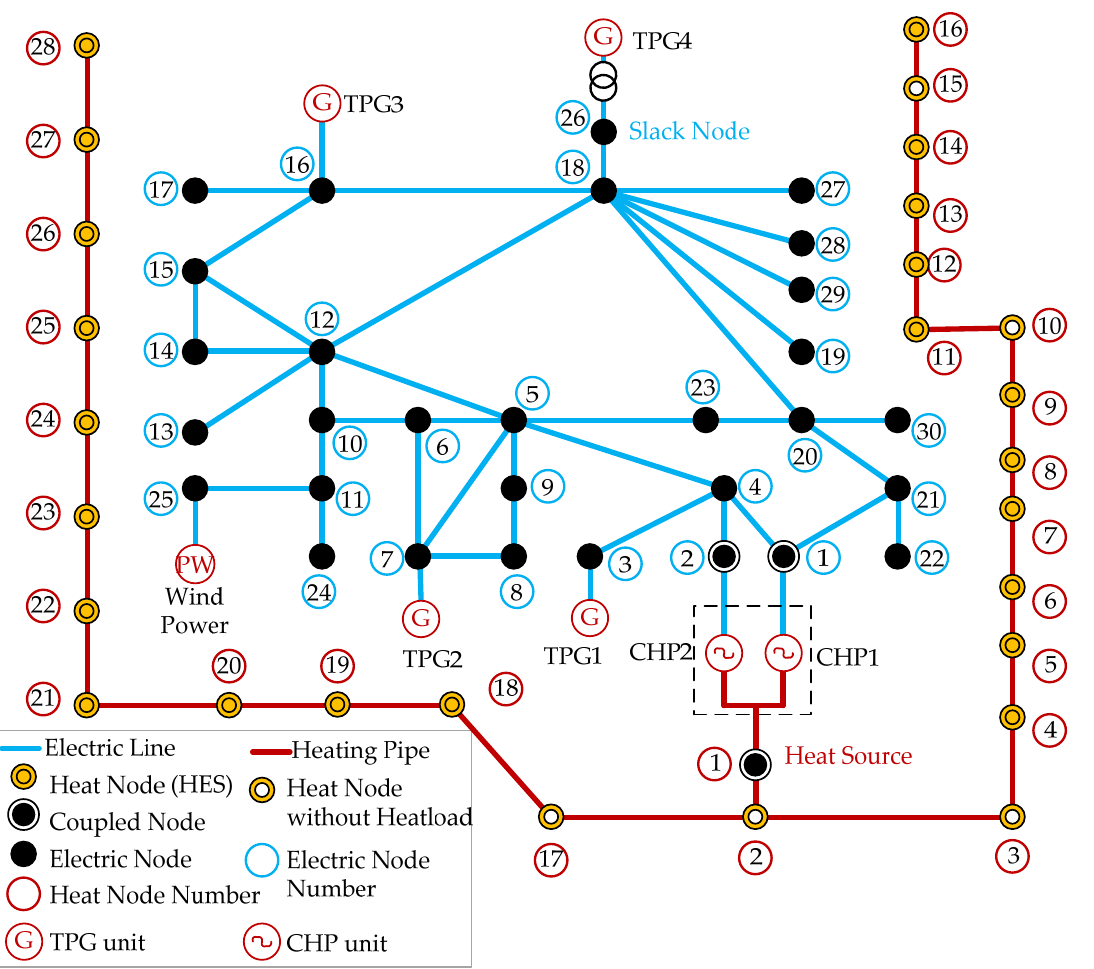
Figure 4. ( a ) Load curve and ( b ) predicted wind power curve.